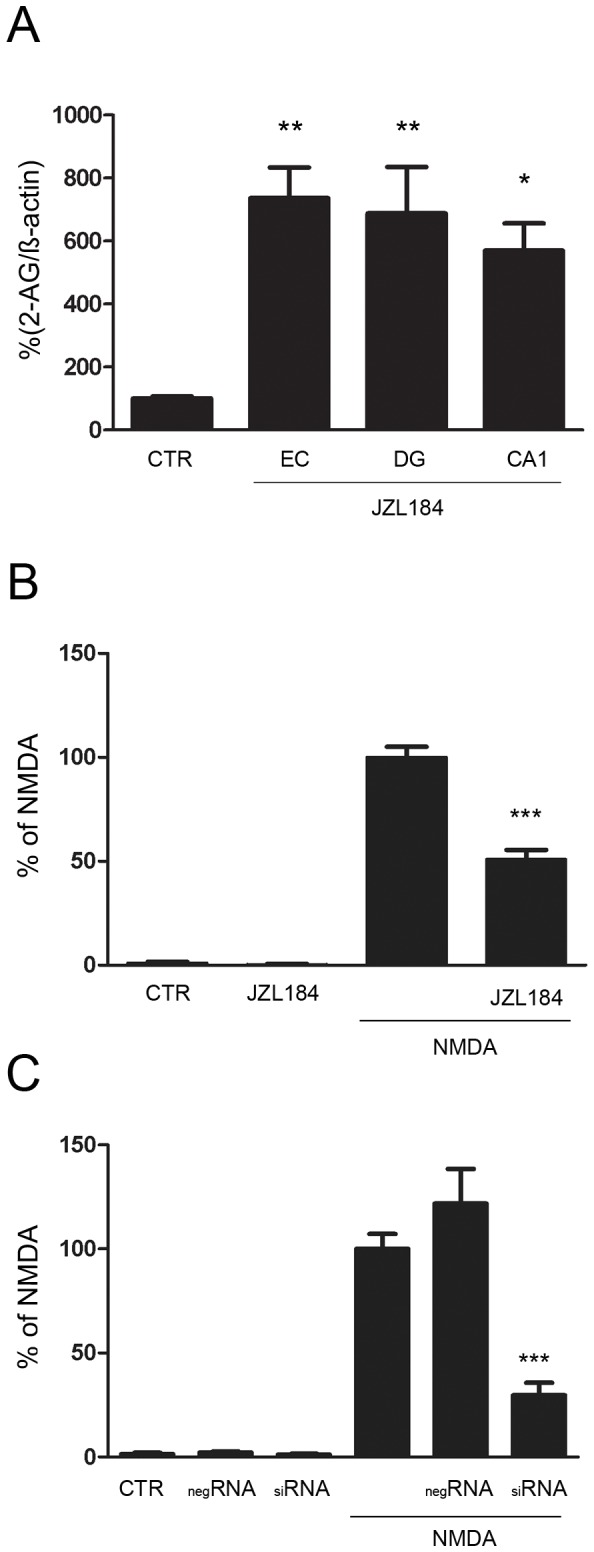
Inhibition of MAGL by JZL184 and siRNA exerted neuroprotective effects.(A) OHSC were treated for 4 h with JZL184 (1 µM) at 6 div. 2-AG levels were significantly elevated in all investigated (EC, DG, CA1) regions compared to the respective control regions of untreated OHSC. (B) Decreased neuronal cell death was seen in excitotoxically lesioned OHSC treated with JZL184 compared to lesioned OHSC treated with NMDA alone. (C) MAGL knock down by siRNA reduced the number of degenerating neurons after NMDA-lesion. (n>3, * = p<0.05, ** = p<0.01, *** = p<0.001).